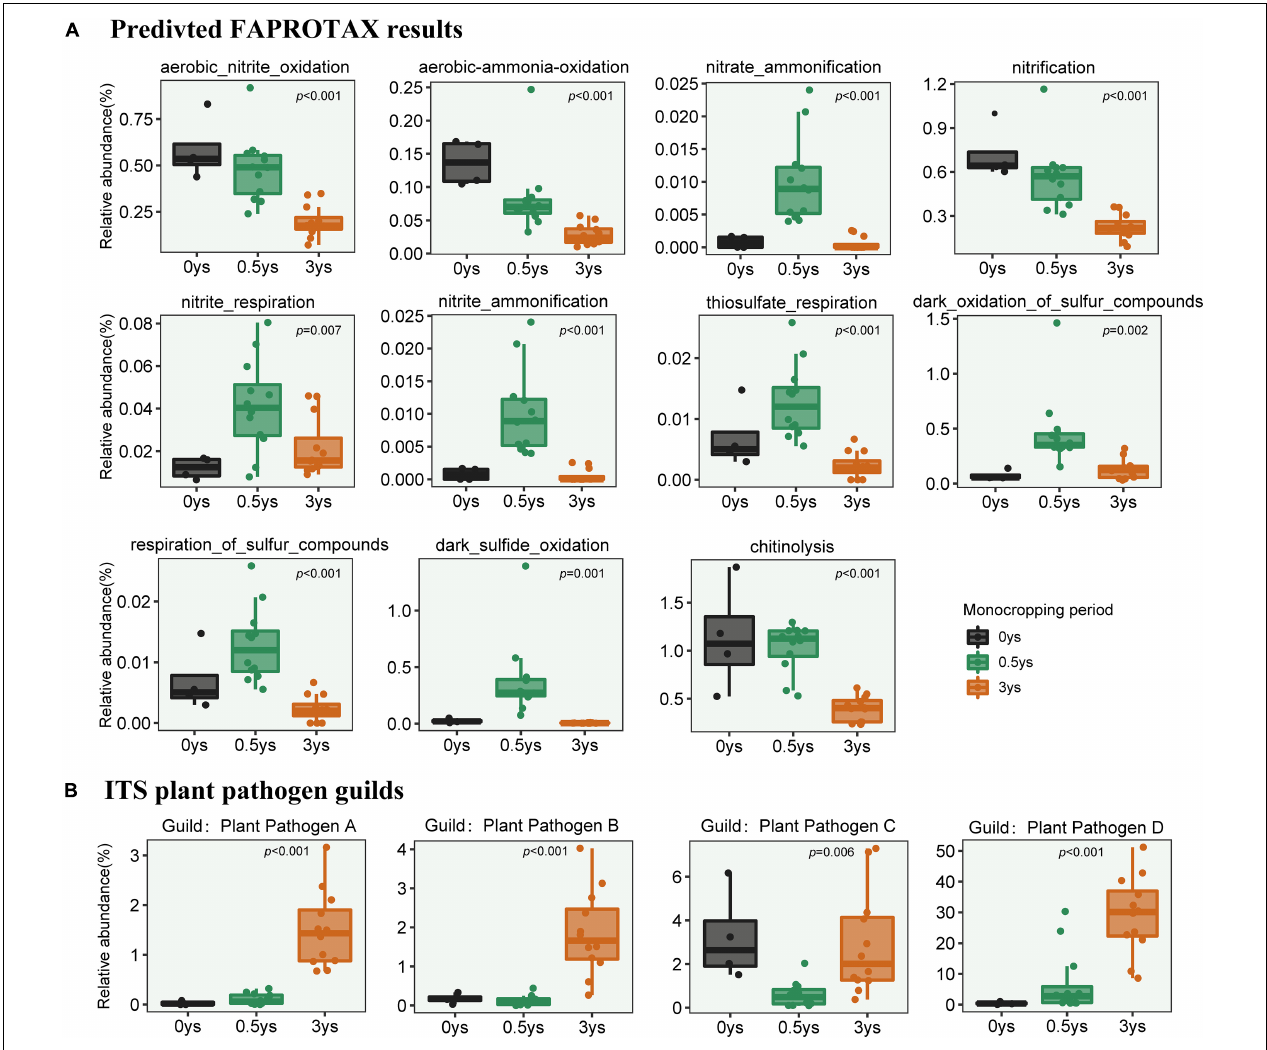
FIGURE 8 | Changes in relative abundance of metabolic pathways in prokaryotic communities based on FAPROTAX (A) and variation of abundance of plant pathogen guilds based on FUNGuild (B) . ANOVA was used to test the significance of